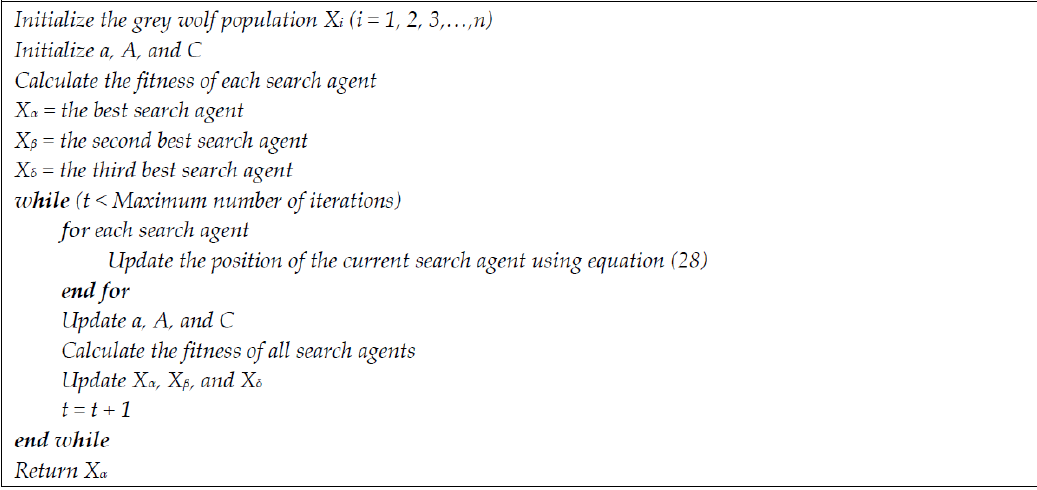
Figure 2. Pseudo code of the Grey Wolf Optimizer algorithm.